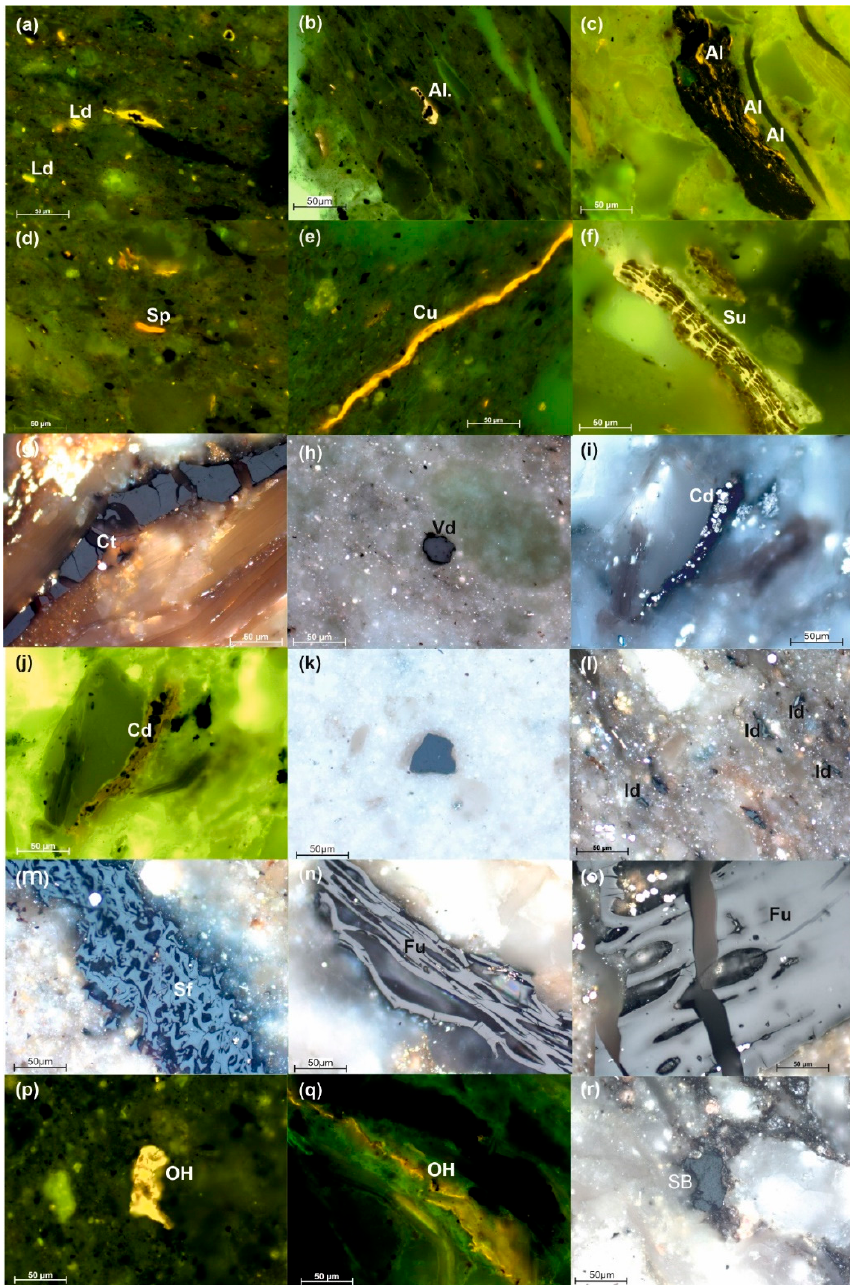
Figure 3. Microphotographs of organic matter: ( a ) typical liptodetrinite (Ld) particles in the Szlach- towa Fm, oil immersion, florescent light; ( b ) alginite in clay mineral matrix, Szlachtowa Fm-oil im- mersion; ( c ) flattened alginite (Al) in organic debris-Szlachtowa Fm, oil immersion, fluorescent light; ( d ) compressed sporinite (Sp) in clay minerals-Szlachtowa Fm, oil immersion, fluorescent light; ( e ) laminae of cutinite (Cu) parallel to the bedding plane in the Szlachtowa Fm, oil immersion, fluores- cent light; ( f ) suberinite (Su) in the Kapu ś nica Fm, oil immersion, reflected light; ( g ) collotelinite (Ct) lamineae–Type A of vitrinite in the Szlachtowa Formation, oil immersion, reflected light; ( h ) well- rounded vitrodetrinite particle in the Szlachtowa Fm, oil immersion, reflected light; ( i ) collodetrinite (Cd) Type B of vitrinite impregnated by pyrite, the Szlachtowa Fm, oil immersion, reflected light; ( j ) the same photo as in ( i ), an example of collodetrinite (Cd) in oil immersion, fluorescent light; ( k ) sharp-edged vitrodetrinite (Vd) grain as Type C, the Jarmuta Fm, oil immersion, reflected light; ( l ) inertodetinite (Id) scattered in the clay minerals, the Szlachtowa Fm, oil immersion, reflected light; ( m ) empty cell lumens in semifusinite (Sf), the Szlachtowa Fm, oil immersion, reflected light; ( n ) arched and flattened fusinite (Fu), the Szlachtowa Fm, oil immersion, reflected light; ( o ) large parti- cle of fusinite (Fu), oil immersion, reflected light; ( p ) and ( q ) liquid hydrocarbons (OHs) penetrating